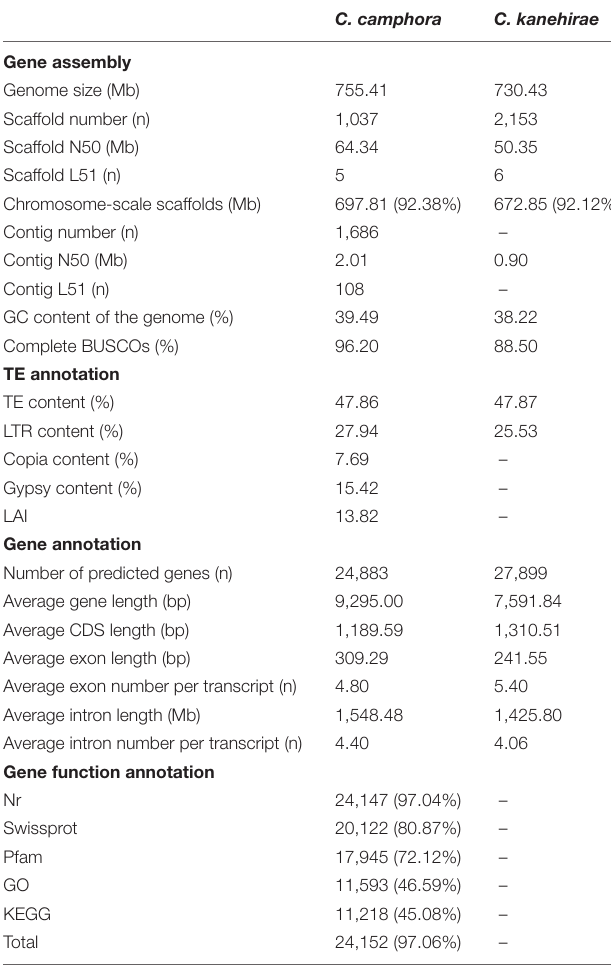
TABLE 1 | The statistics for genome sequencing of Cinnamomum